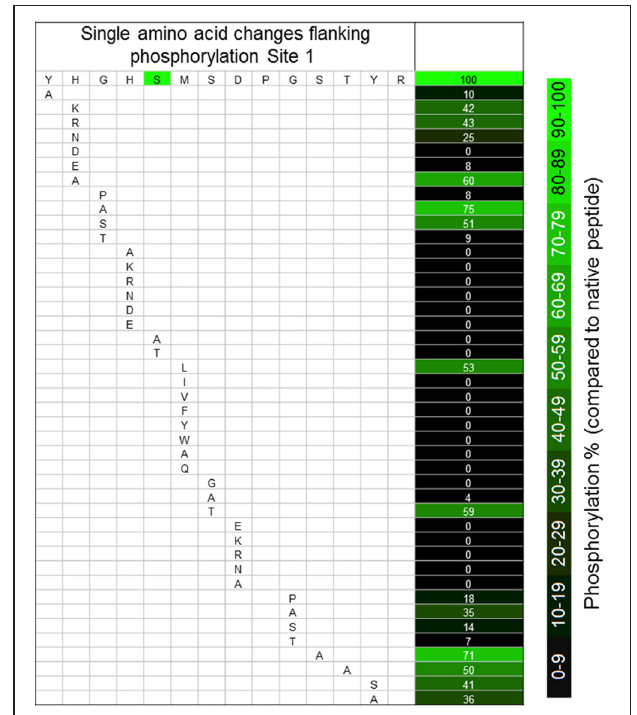
FIGURE 2 | The effects of single amino acid changes to the sequences flanking phosphorylation site 1 of A . thaliana PDC E1 α . Values are percentage changes compared with the native sequences, and are the means of three technical